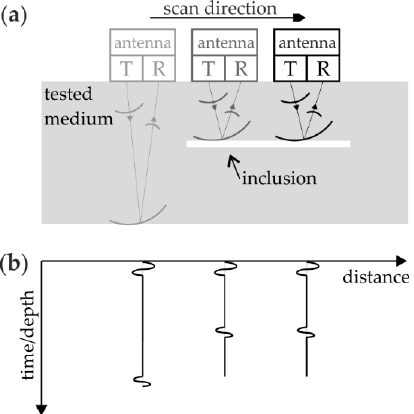
Figure 5. Scheme of measurements performed in pulse ‐ echo mode: ( a ) collection of signals; ( b ) sketch of obtained echogram.